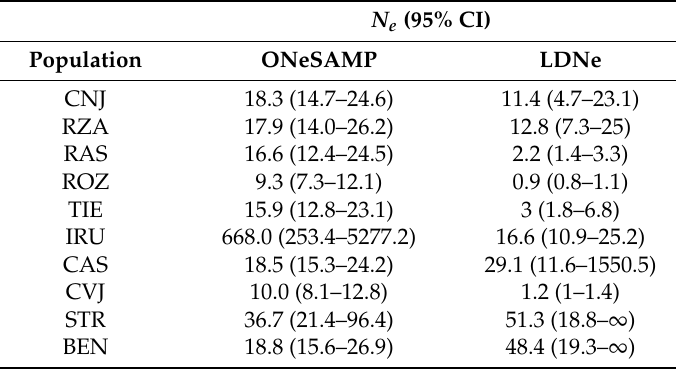
Table 5. Estimates for the effective population size ( N e ) in the 10 Ulmus glabra populations (see Table 1 for codes) with at least 20 sampled individuals, using approximate Bayesian computation (ONeSAMP v. 1.1) and linkage–disequilibrium information (LDNe v. 1.31). In parentheses are the lower and upper values at 95% confidence intervals